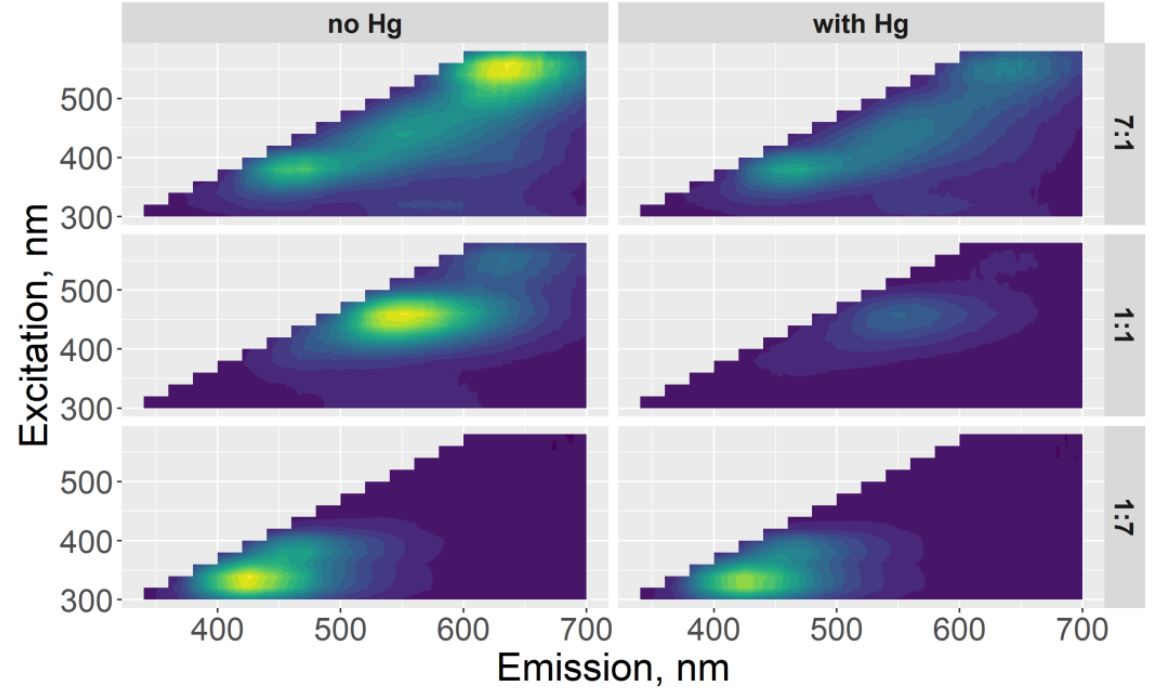
Figure 10. Effect of addition of 10 µmol/L of Hg(NO 3 ) 2 on the map of emission spectra of purified samples prepared from urea and citric acid. The presence of mercury(II) and the sample composition (urea: citric acid) are shown in the subplot captions.